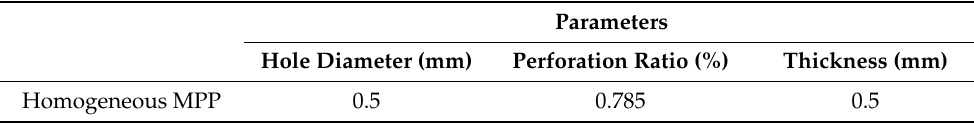
Table 3. Parameters of the homogeneous MPP used for